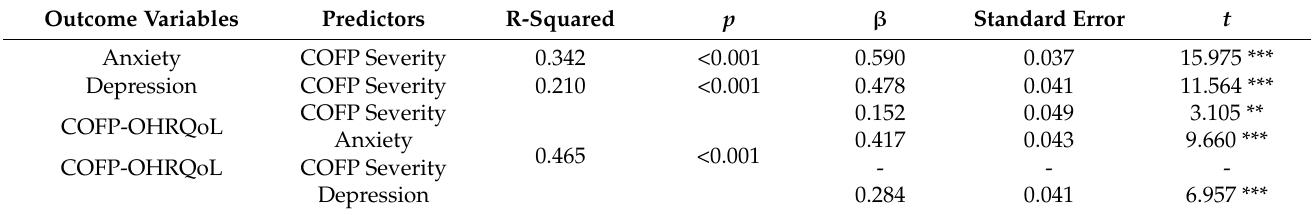
Table 3. Results regarding the mediation effect of anxiety and depression.